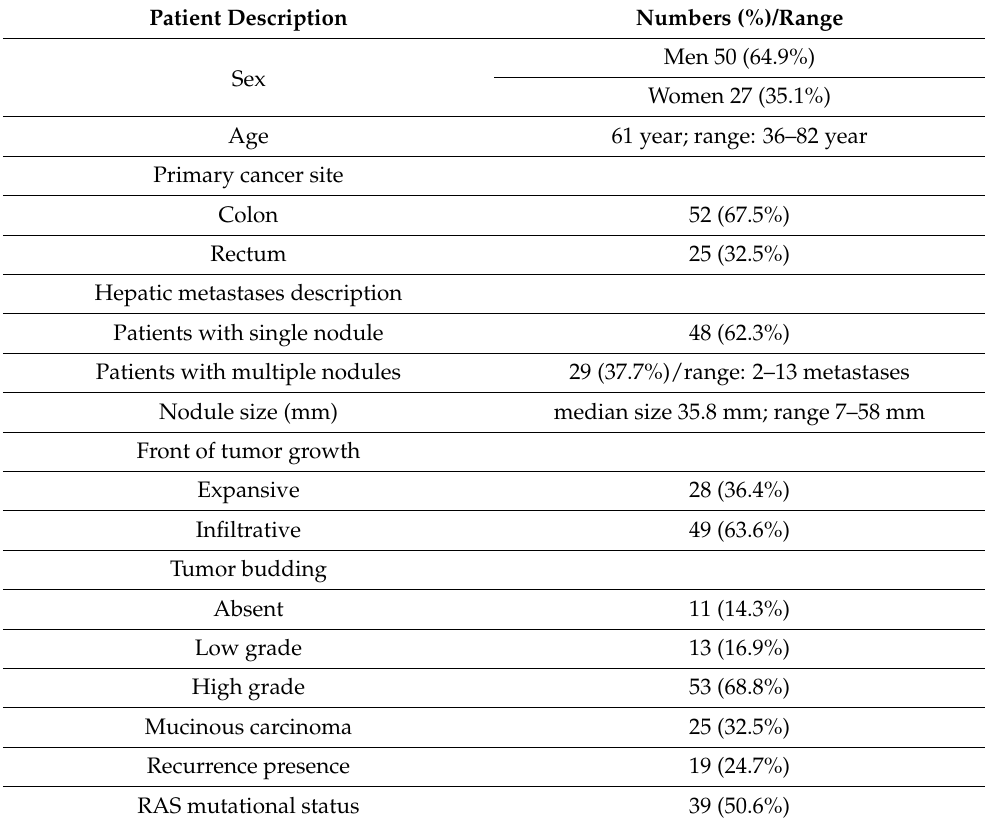
Table 1. Characteristics of the study population (77